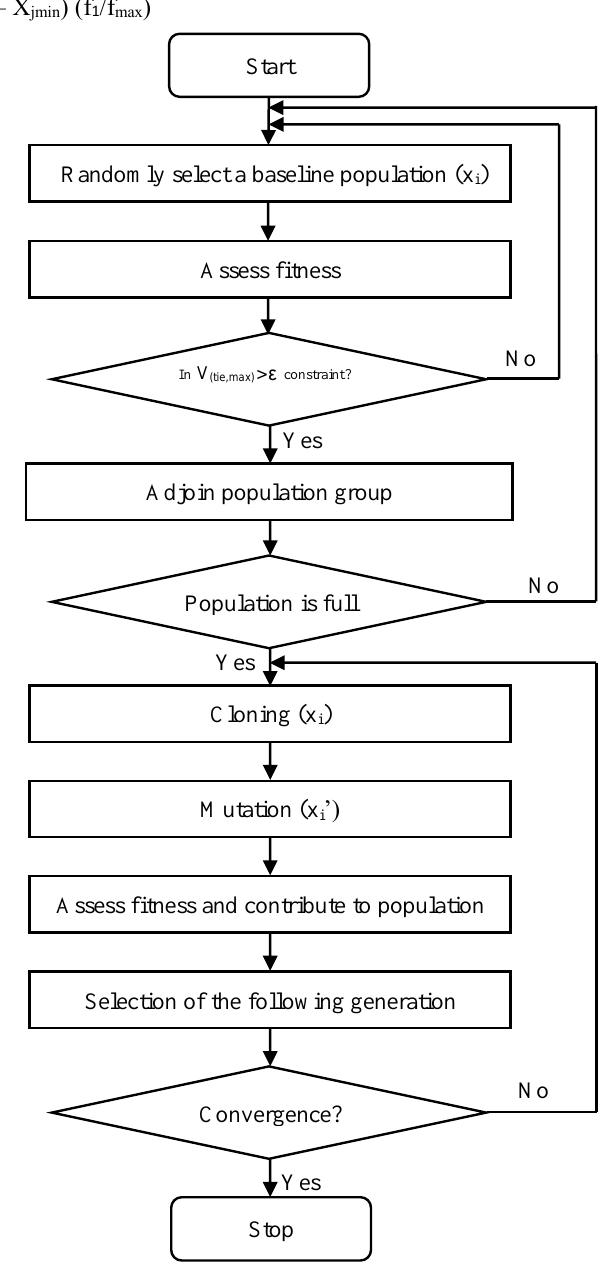
Figure 2. The procedure of ICS